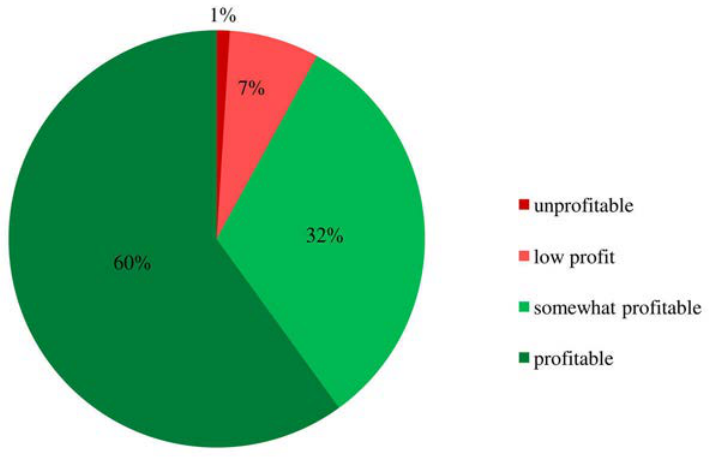
Fig. 3. Structure of responses to the question about the profitability of fruit production. Source: survey